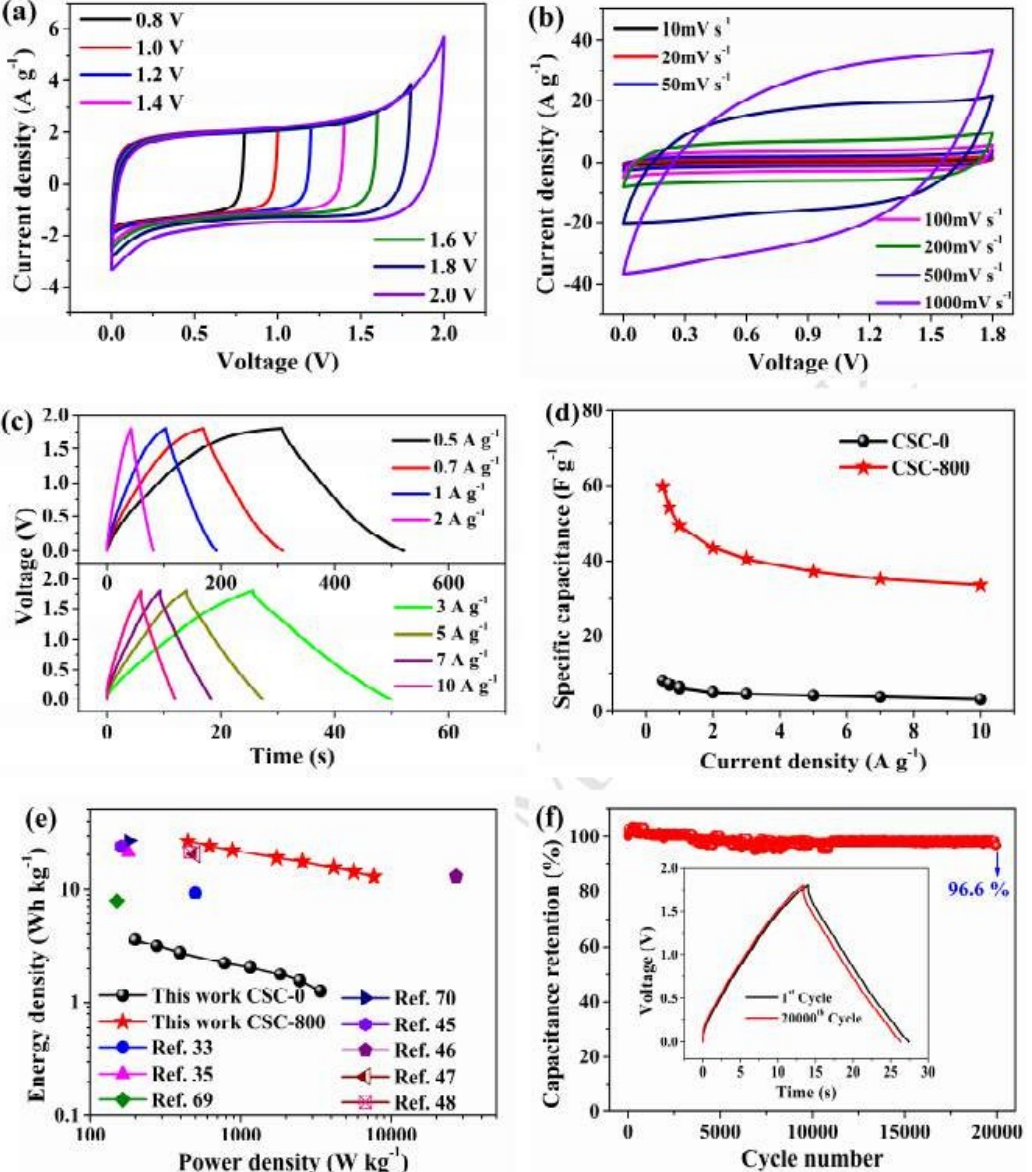
Figure 29. EC study of the CSC-800/CSC-800: ( a ) CV curves with different voltages; ( b ) CV curve with a range of scan rates from 10 to 1000 mV s − 1 ; ( c ) GCD curves with a different CD; ( d ) Csp vs. CD; and ( e , f ) Ragone plots. Reproduced with permission from [110].